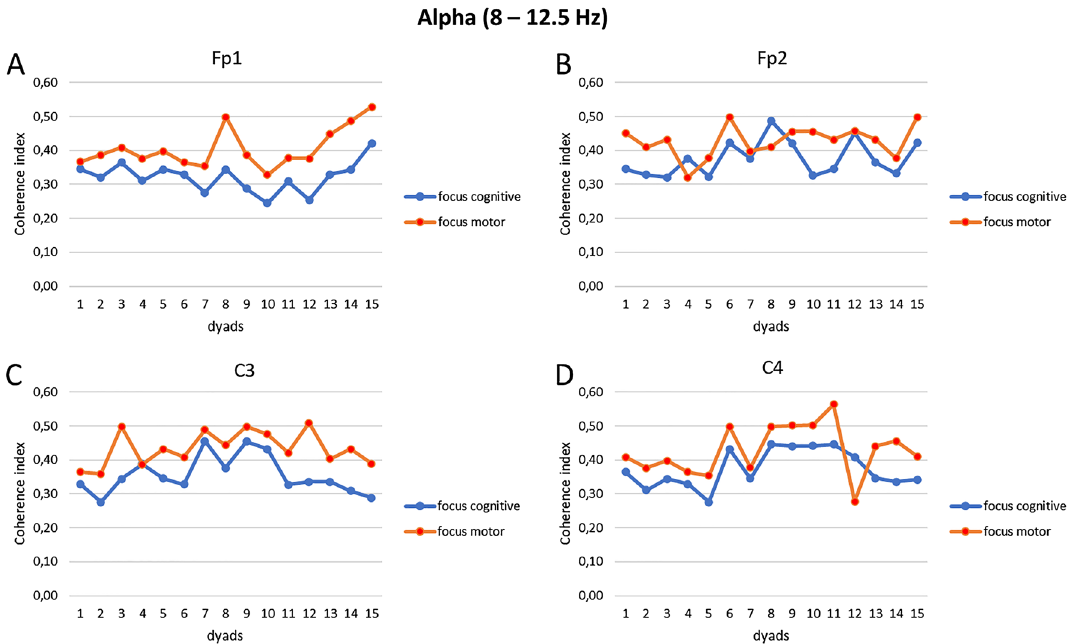
Figure 2. ( A – D ) EEG coherence indices for alpha band. Trend of the coherence indices modulation as a function of the synchronization tasks for the electrodes Fp1 ( A ), Fp2 ( B ), C3 ( C ), and C4 ( D ) in each